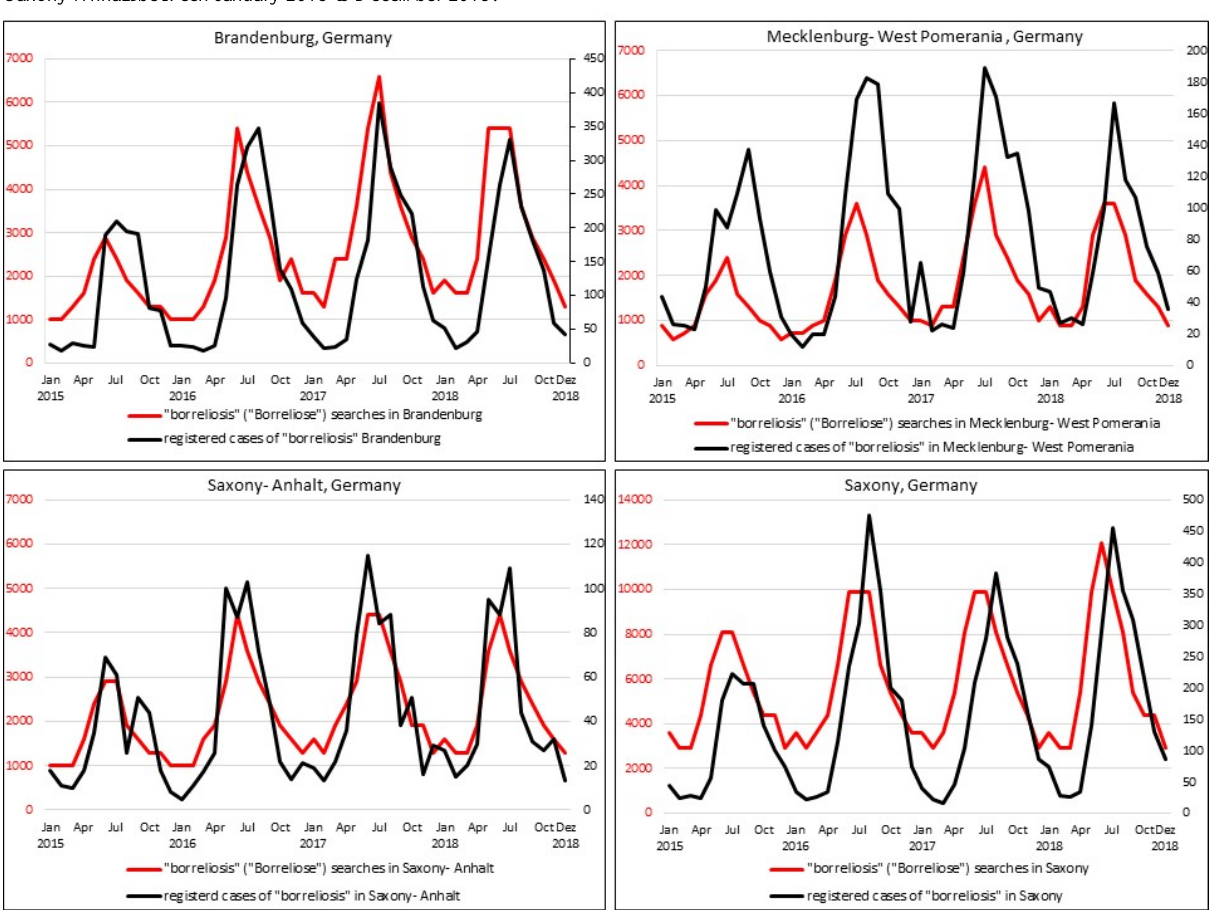
Figure 4. Number of Google searches for "borreliosis" with registered cases of borreliosis in Brandenburg, Mecklenburg-West Pomerania, Saxony, and Saxony-Anhalt between January 2015 to December 2018.